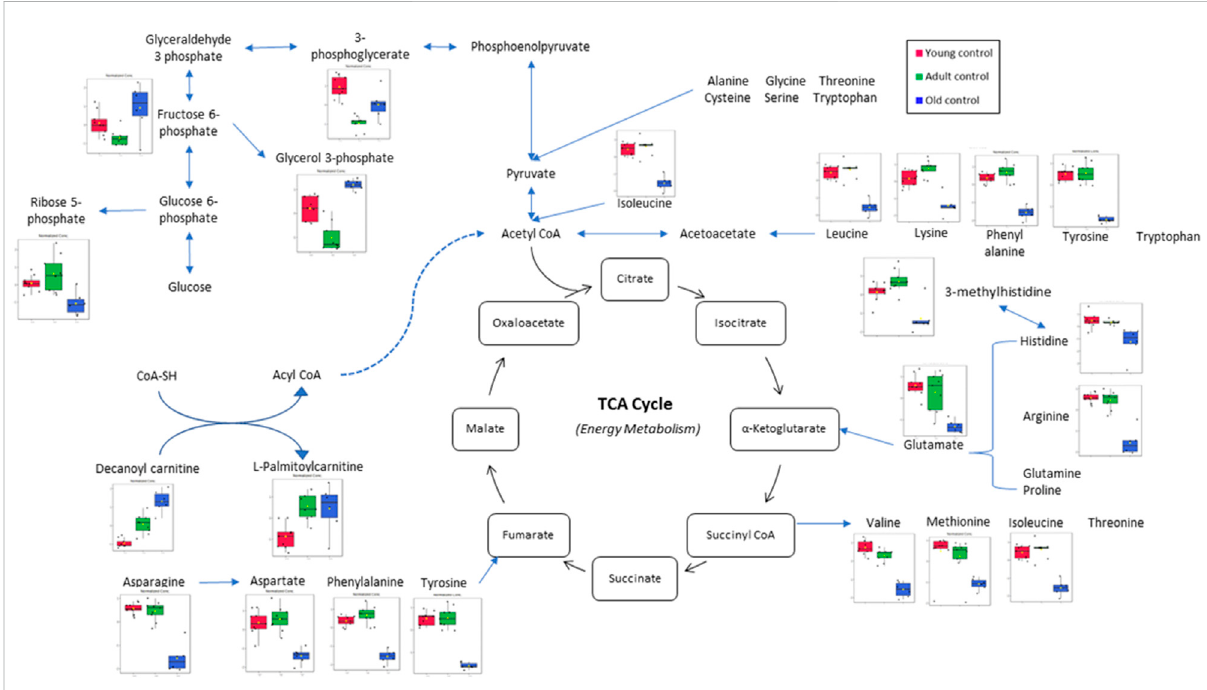
FIGURE 8 Muscle metabolomes changes in ageing rats. Metabolite concentrations in muscle specimens are depicted graphically and subjected to quantitative analysis. Box and whiskers plots with 95% con fi dence intervals are presented for quanti fi ed amino acids. Analysis was performed using one-way Anova with Tukey ’ s post hoc analysis. *p <